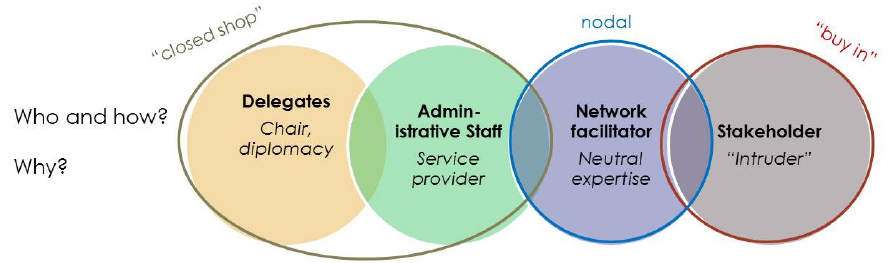
Figure 2. Operational roles.